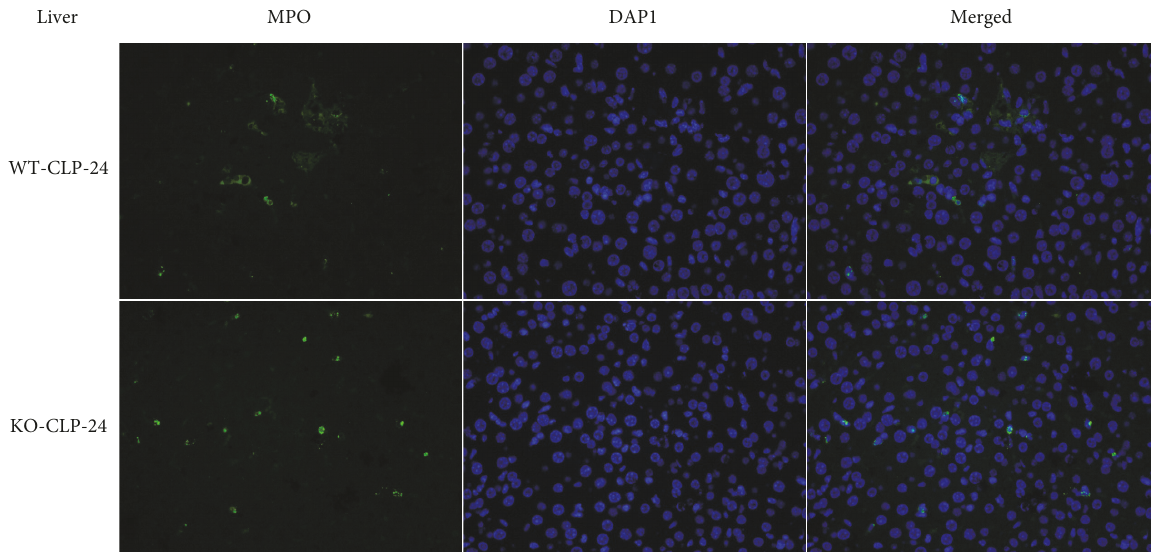
Figure 12: Lack of 5-HT decreases the level of MPO in the liver in CLP-induced sepsis. MPO staining of the liver tissue at 24 h after CLP administration. The MPO-stained cells (green), the corresponding nuclear counterstaining (blue), and both channels merged display the relative change in the level of MPO observed in a typical fi eld. The MPO staining was signi fi cantly decreased in the KO-CLP sepsis group compared to the WT-CLP sepsis group in the liver at 24h after the CLP. Original magni fi cations, × 400.